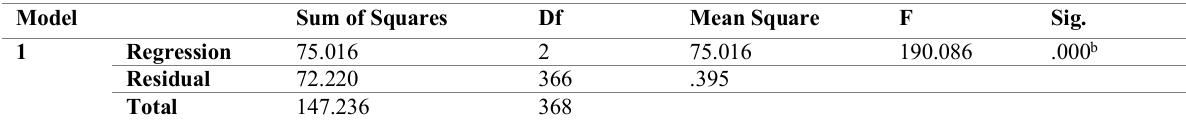
Table 9: ANOVA test for achievement-oriented leadership style